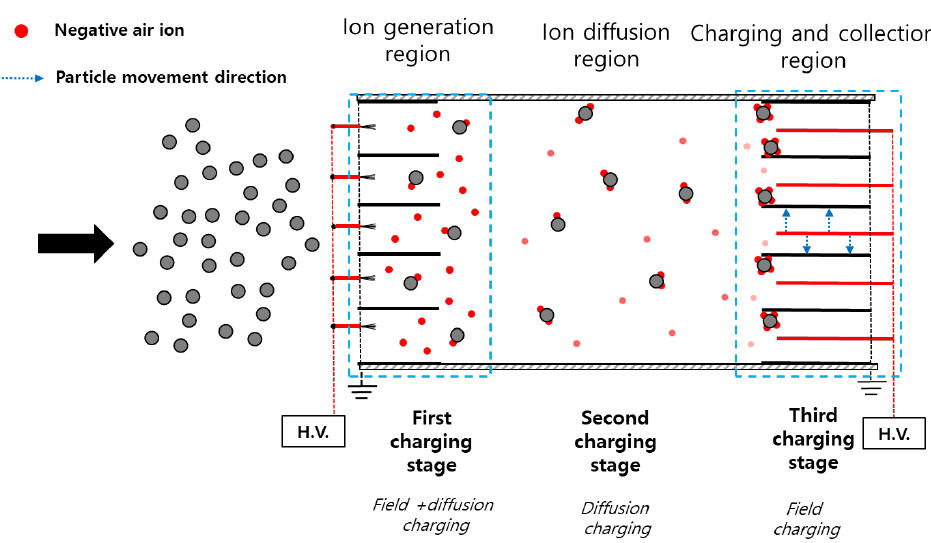
Figure 9. Schematic of the modified charging mechanism of the two-stage electrostatic precipitator using carbon fiber ionizers with the charger and collector separated. using carbon fiber ionizers with the charger and collector